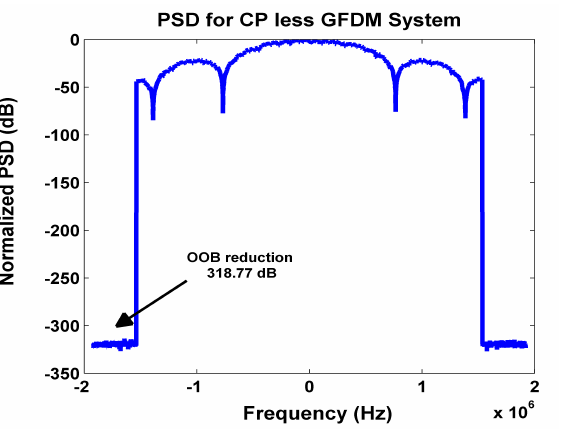
Figure 11. Power spectral density of the proposed system for typically chosen case of mMTC user